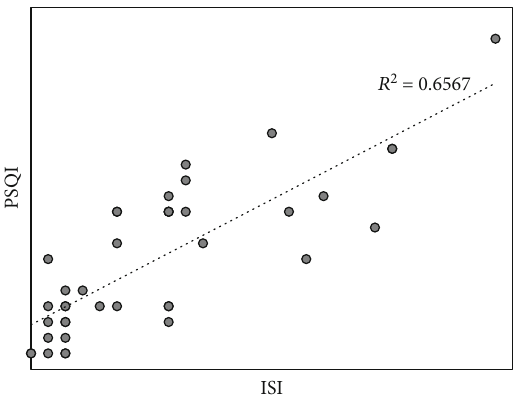
Figure 2: Scatterplot of ISI and PSQI